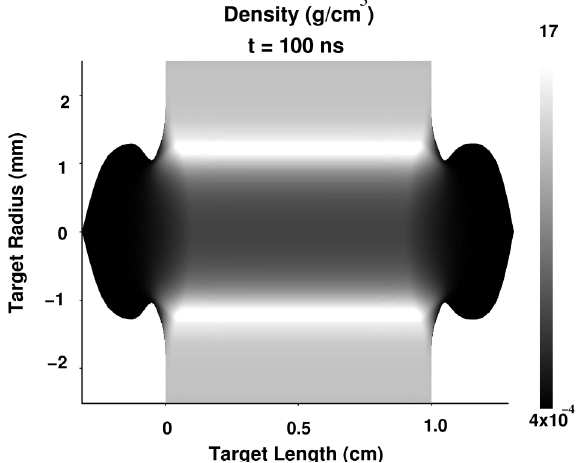
FIG. 7. Density at t (cid:3) 100 ns corresponding to the case shown in Fig.